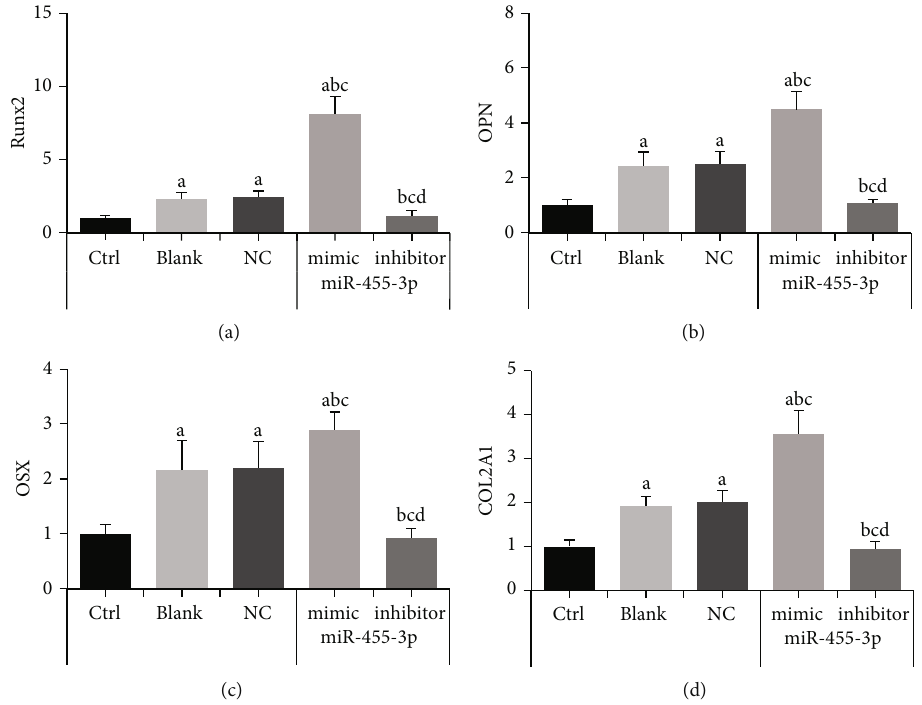
Figure 6: Detection of Runx2, OPN, OSX, and COL2A1 mRNA in BMSCs. (a – d) The relative expressions of Runx2, OPN, OSX, and COL2A1 mRNA, respectively. Note: A, B, C, and D meant P < 0 : 05 in comparison to the Ctrl, blank, NC, and mimic groups,